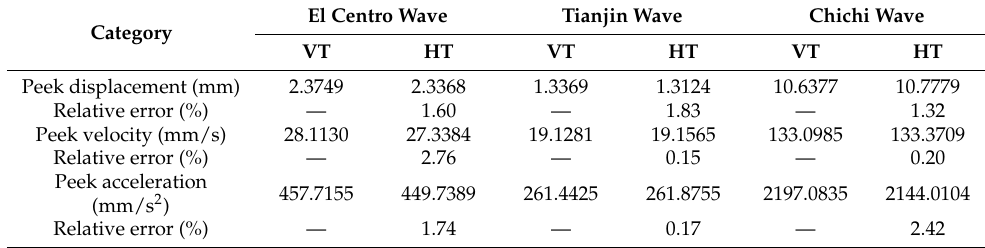
Table 2. Comparative analysis of Model